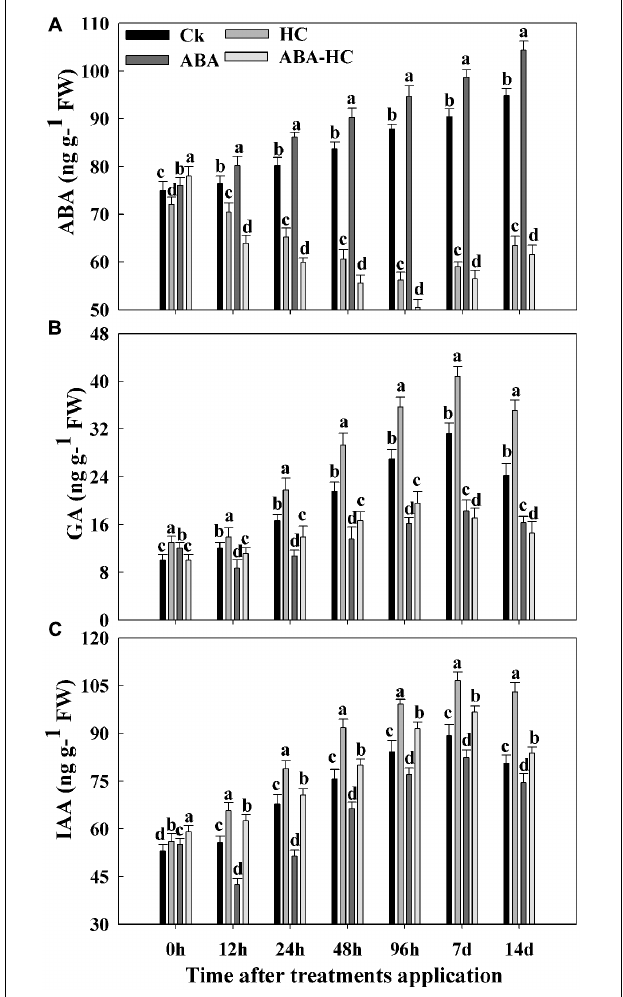
FIGURE 2 | Effect of HC, ABA, and ABA-HC on contents of (A) ABA, (B) GA, and (C) IAA in the buds of cv. ‘Shine Muscat.’ The mesurements in treated and control bud samples were made at 0, 12, 24, 48, 96 h, 7 and 14 days after treatement. Verticle lines above the means bars indicate standard error ( n = 3; p = 0.05) using Tukey’s HSD post hoc test. a–d represents significant difference between